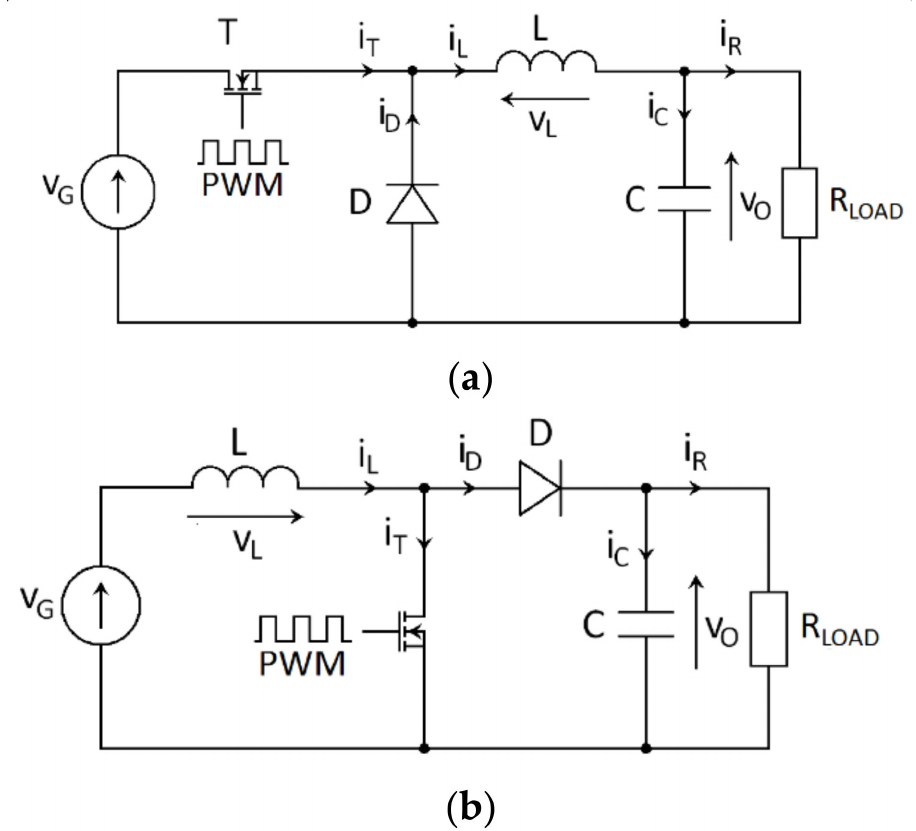
Figure 2. DC/DC converters commonly used for MPPT systems: ( a ) buck and ( b )